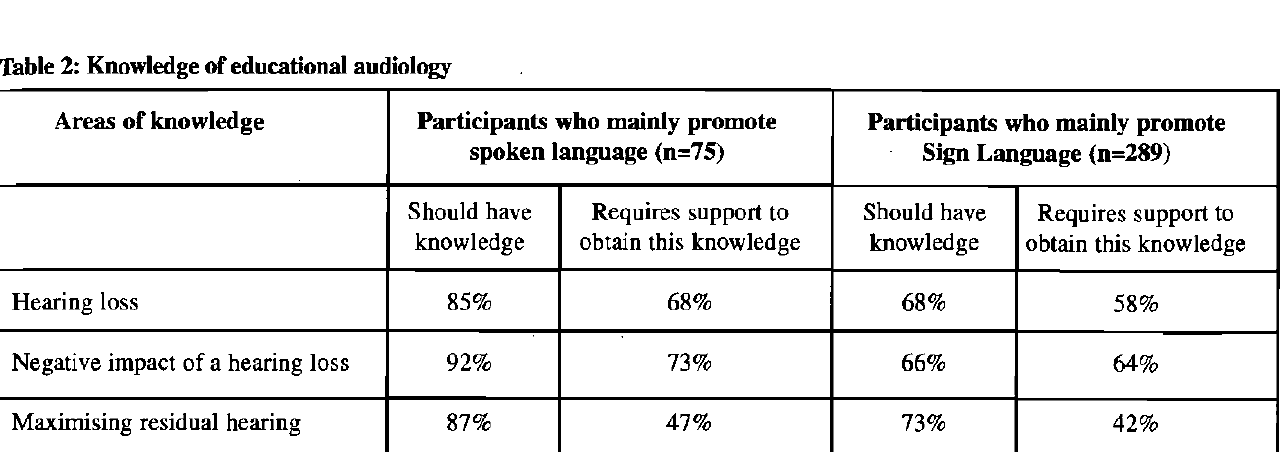
Table 2: Knowledge of educational audiology Areas of knowledge Participants who mainly promote